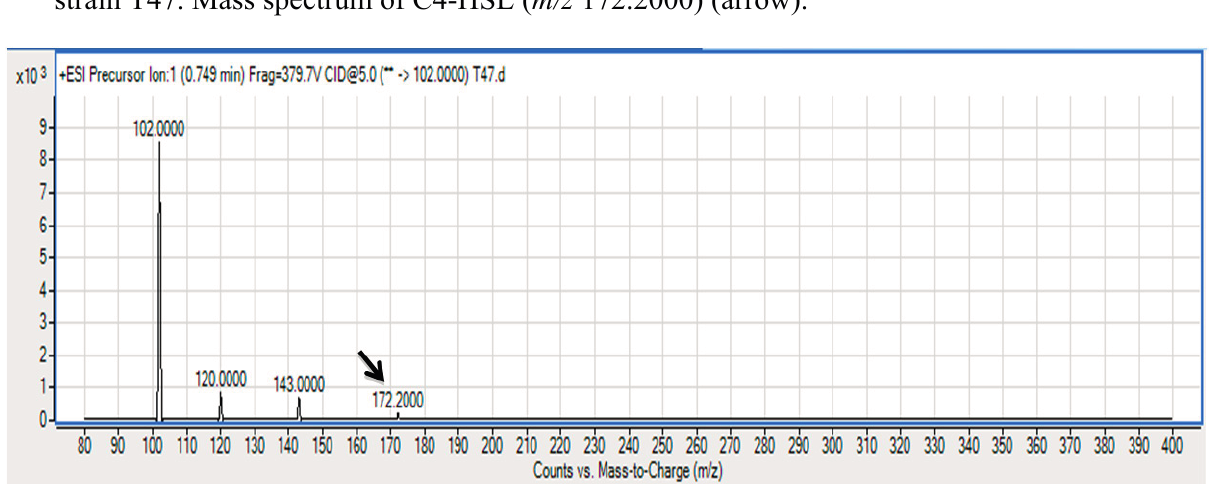
Figure 3. Mass spectrometry analysis of spent supernatants extract of Vibrio